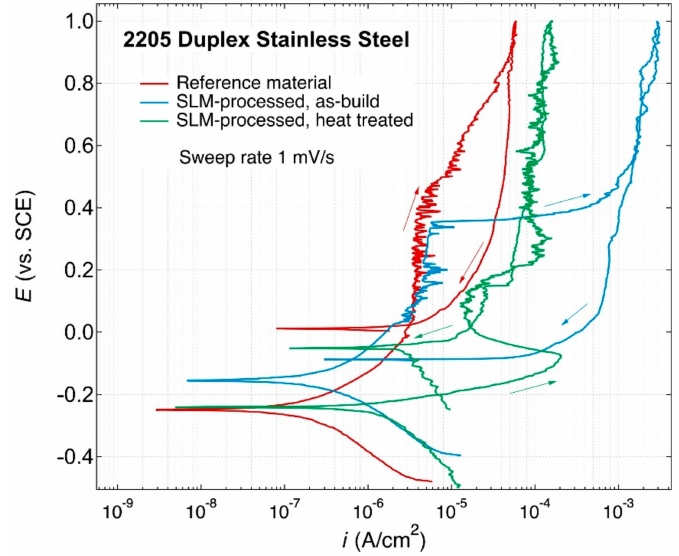
Figure 11. Cyclic potentiodynamic polarization curves of as-received cold-rolled and annealed reference alloy 2205, as-SLM-processed DSS 2205 and SLM-processed DSS 2205 with post-heat treatment in neutral 0.6 M NaCl solution at room temperature, respectively. The arrows indicate the polarization